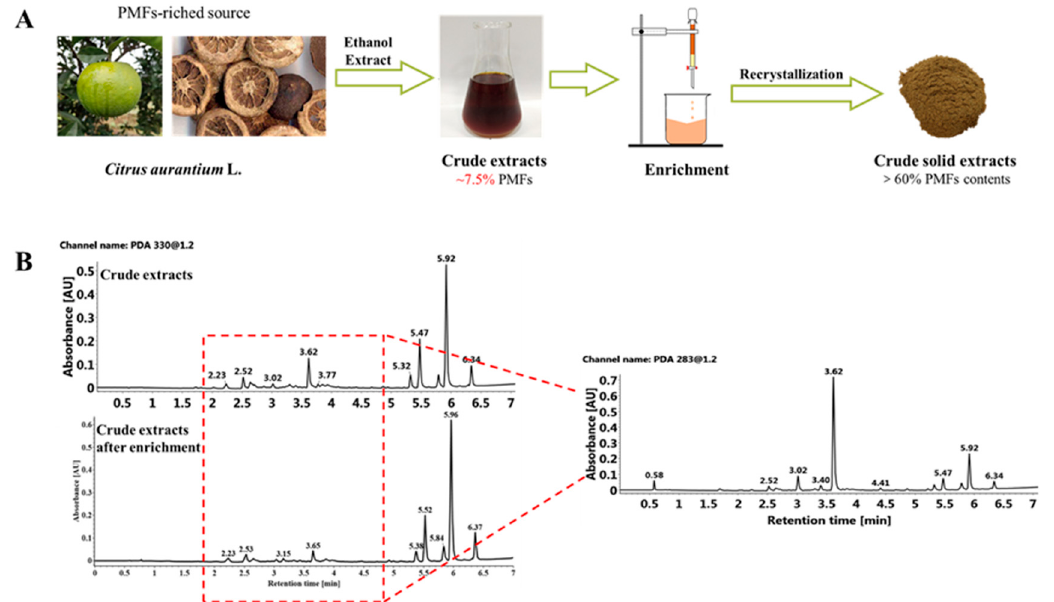
Figure 2. Purification of PMFs in sour orange. ( A ) The experimental design of the purification of PMFs in sour oranges. ( B ) UPLC chromatograms of PMFs before and after purification. PMFs in sour oranges. ( B ) UPLC chromatograms of PMFs before and after